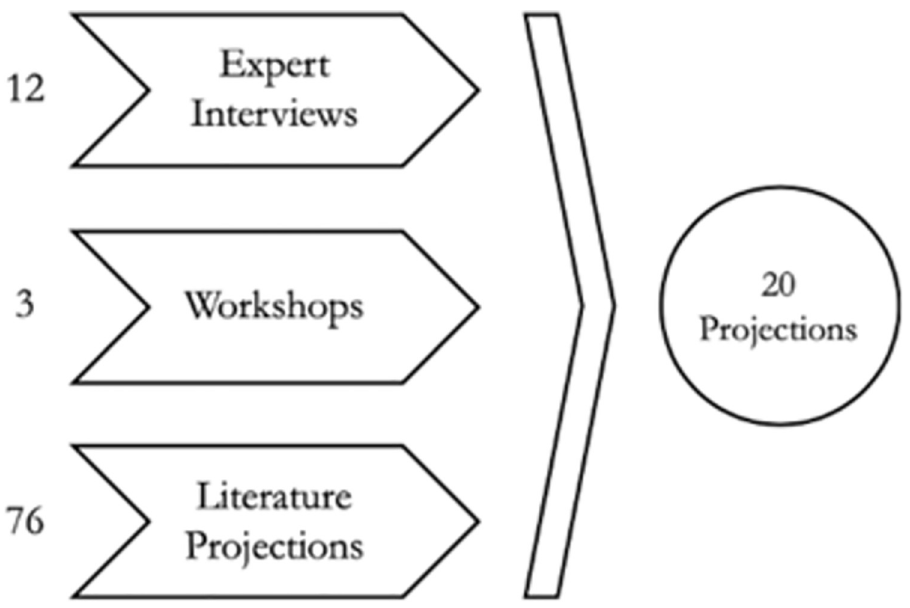
Fig 2. Process followed to generate the final Delphi